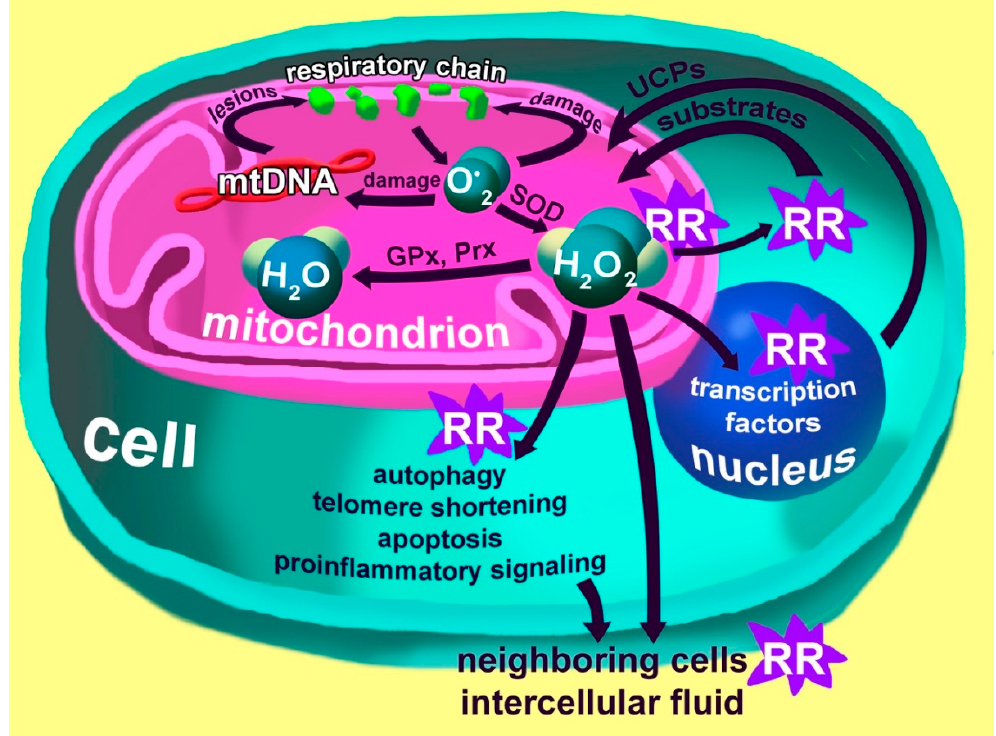
Figure 2. Generation of reactive oxygen species (ROS) by the mitochondrial respiratory chain. Superoxide anions generated by the respiratory chain damage the respiratory chain itself and the mitochondrial DNA, which leads to changes in the respiratory chain that increase the production of the superoxide anion. Superoxide anions also damage the mitochondrial membranes, causing lipid peroxidation and leading to changes in membrane properties. Special superoxide dismutase (SOD) enzymes convert superoxide anions into hydrogen peroxide, which is then converted to water by peroxiredoxins (Prx) and glutathione peroxidase (GPx). Hydrogen peroxide plays a major redox-regulating (RR) role in this system. In mitochondria, it changes the activity of enzymes, in the cytosol, it affects the delivery of substrates into the mitochondria, whereas, in the nucleus, it alters the activity of transcription factors, causing the response kernel, which is reflected in increased protein expression of uncouplers (UCPs). UCPs are transported to the mitochondria, where they reduce the proton potential of the inner membrane, thereby reducing the production of the superoxide anion. Excessive production of hydrogen peroxide in the cytoplasm triggers autophagy processes, causes shortening of telomeres, potentially starts the process of apoptosis and causes increased expression of pro-inflammatory factors that can affect neighboring cells and the whole organism [27].